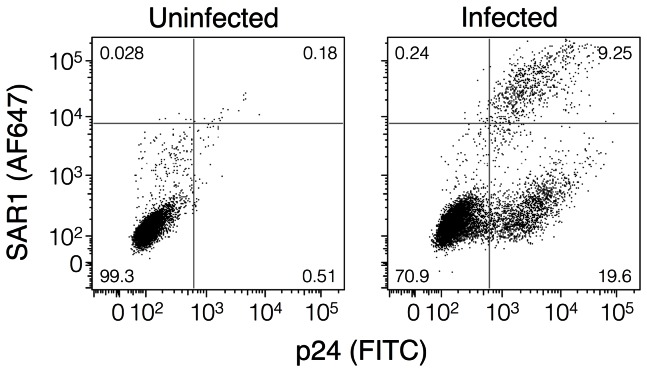
CTT exposure can be detected on virus-infected cells.Unfixed uninfected and HIV-1 89.6-infected CEMx174 cells were surface stained with anti-KE MAb SAR1, and subsequently fixed, permeabilized, and stained with anti-p24 to determine the extent of CTT exposure on virally-infected cells. Dot plots are representative of cells from the live cell population as determined from cellular scatter characteristics.